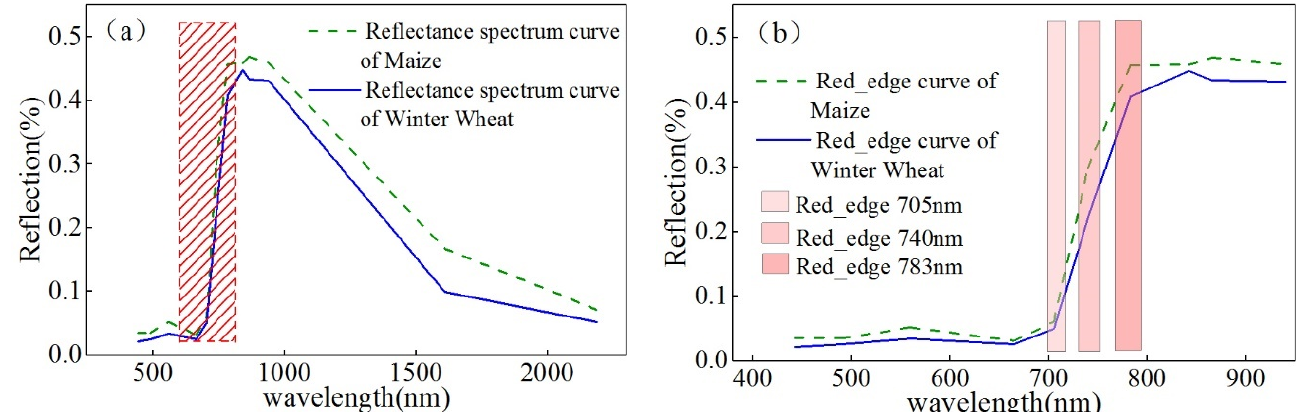
Figure 5. Spectral reflectance curves and variations of crops in red-edge information. ( a ) Spectral curves of winter wheat and maize. ( b ) Variations in the red-edge positions of winter wheat and maize.